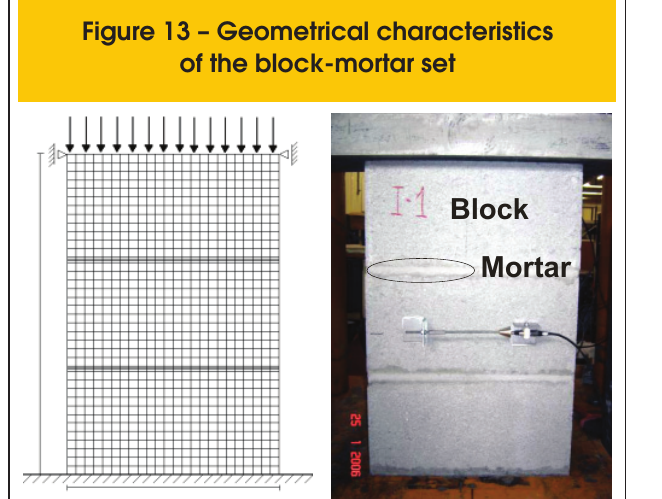
Figure 13 – Geometrical characteristics of the block-mortar set